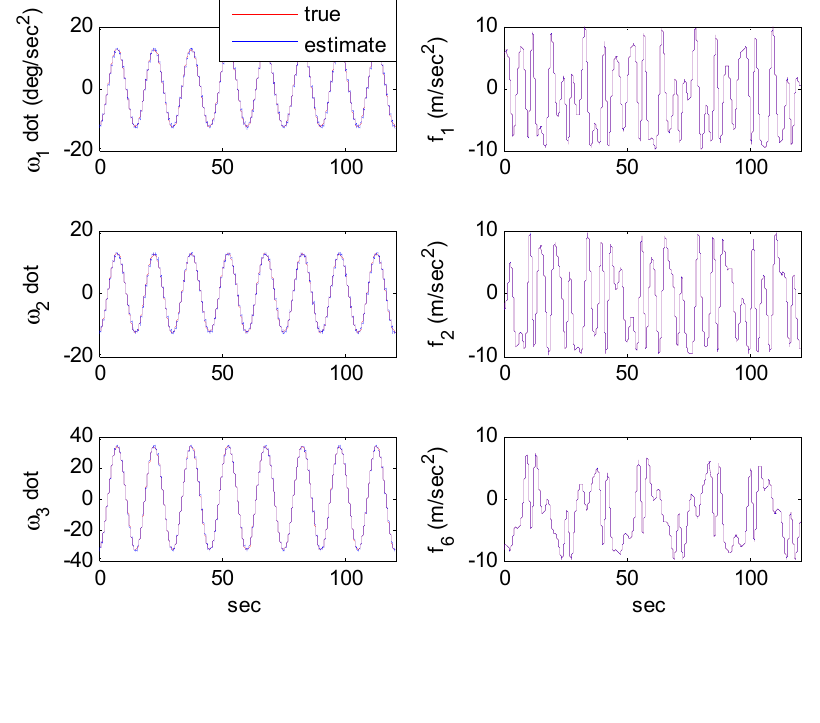
Figure 4. Reference trajectories of angular acceleration and specific force: Case